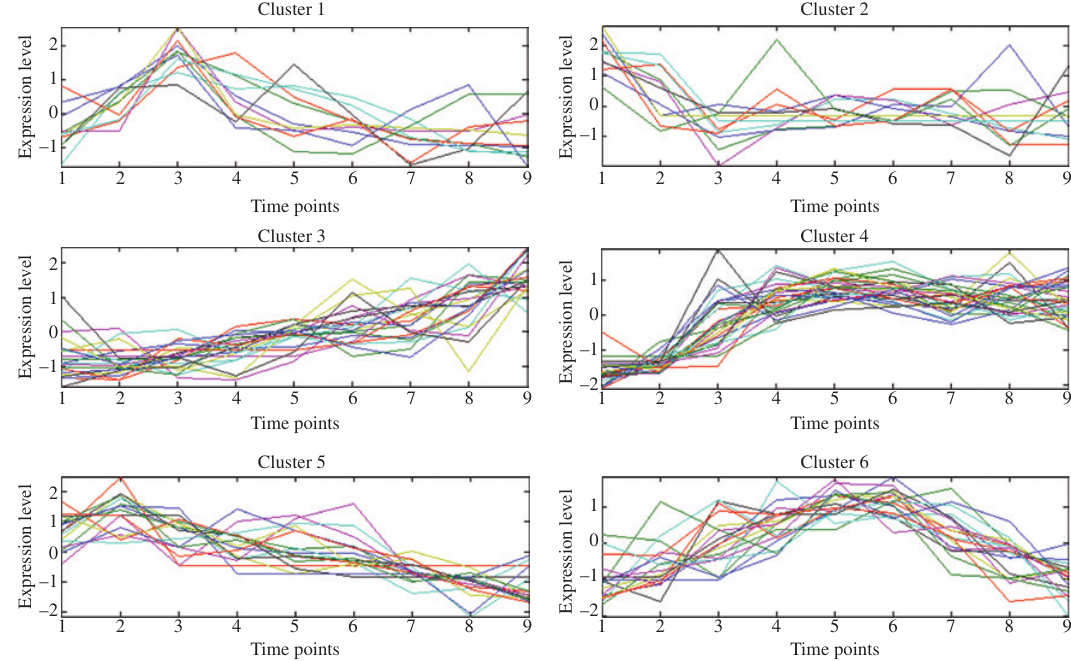
Figure 5: Cluster Profile Plots of Rat CNS Data Clustered Using GWAC.